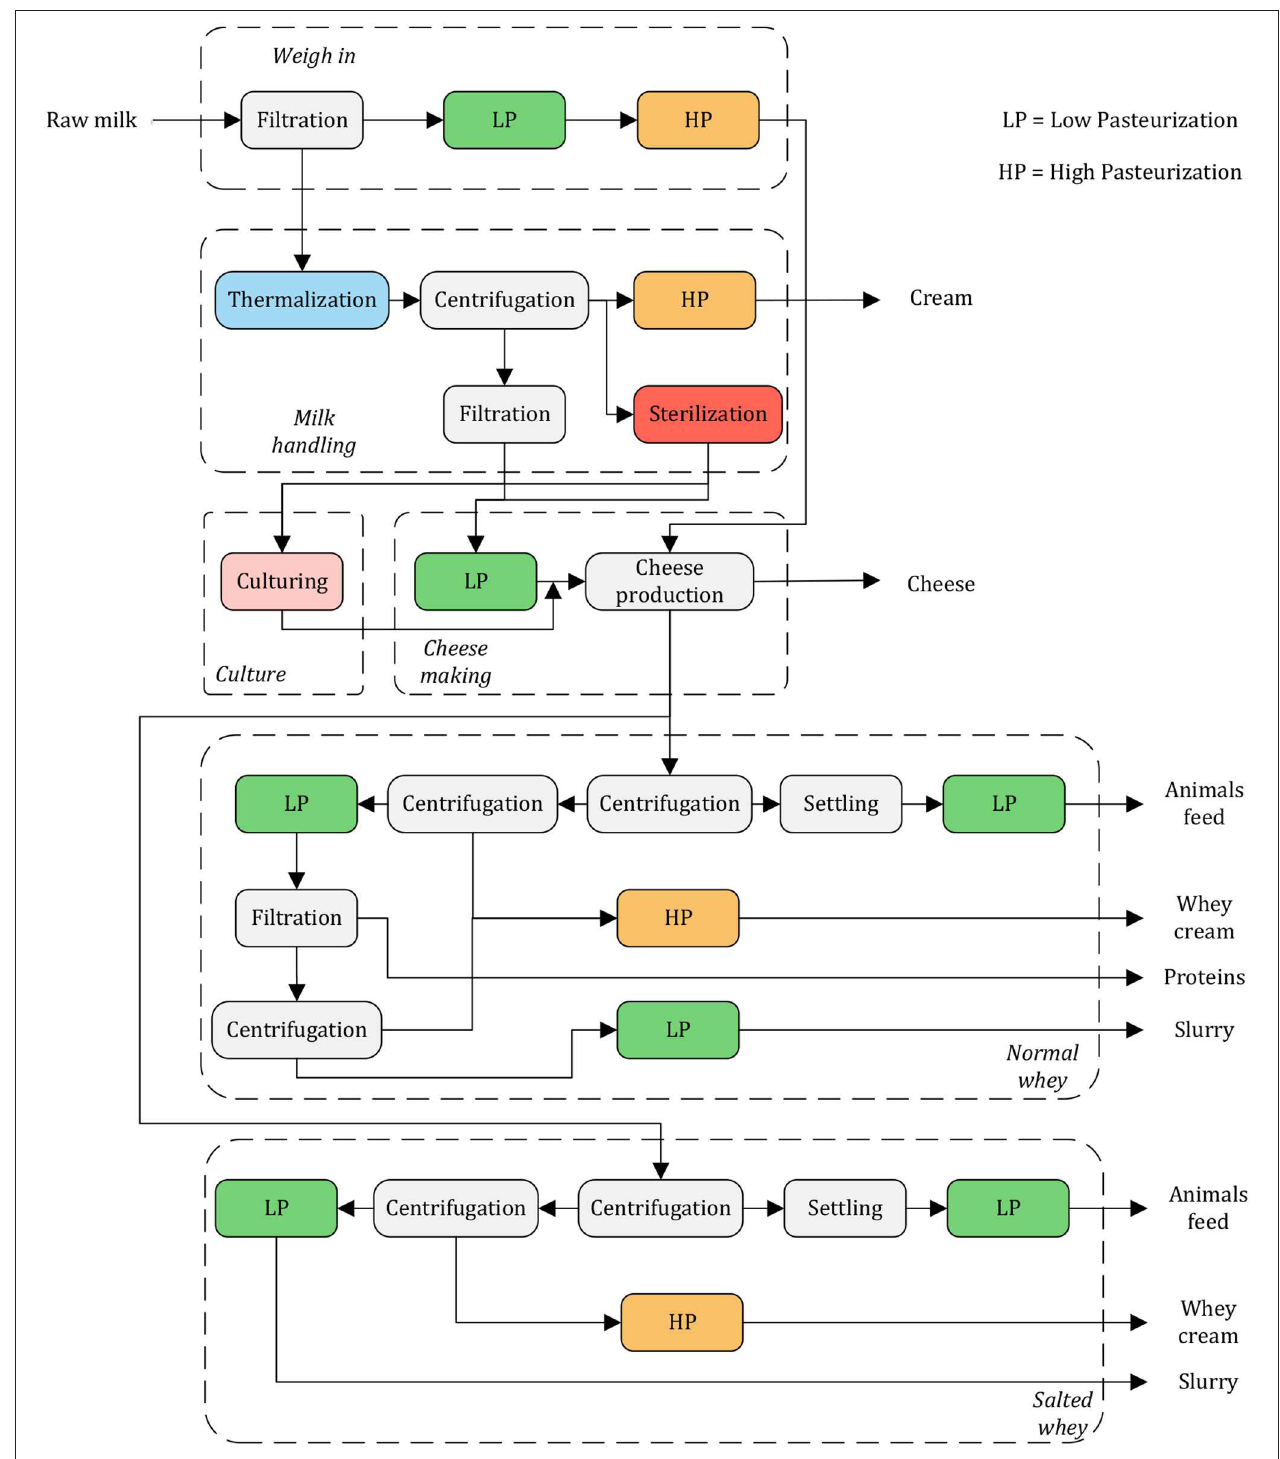
FIGURE 1 | Cheese factory case study conceptual process scheme.